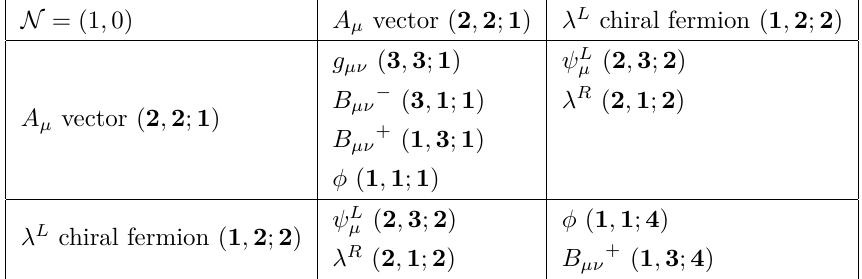
Table 4 . 6d N = (1 , 0) Yang-Mills squared.